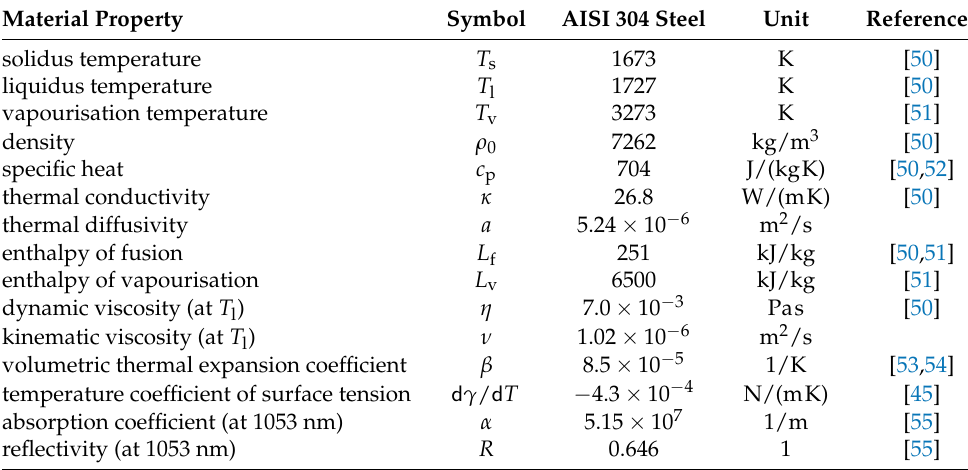
Table 2. Material properties of stainless steel substrates.